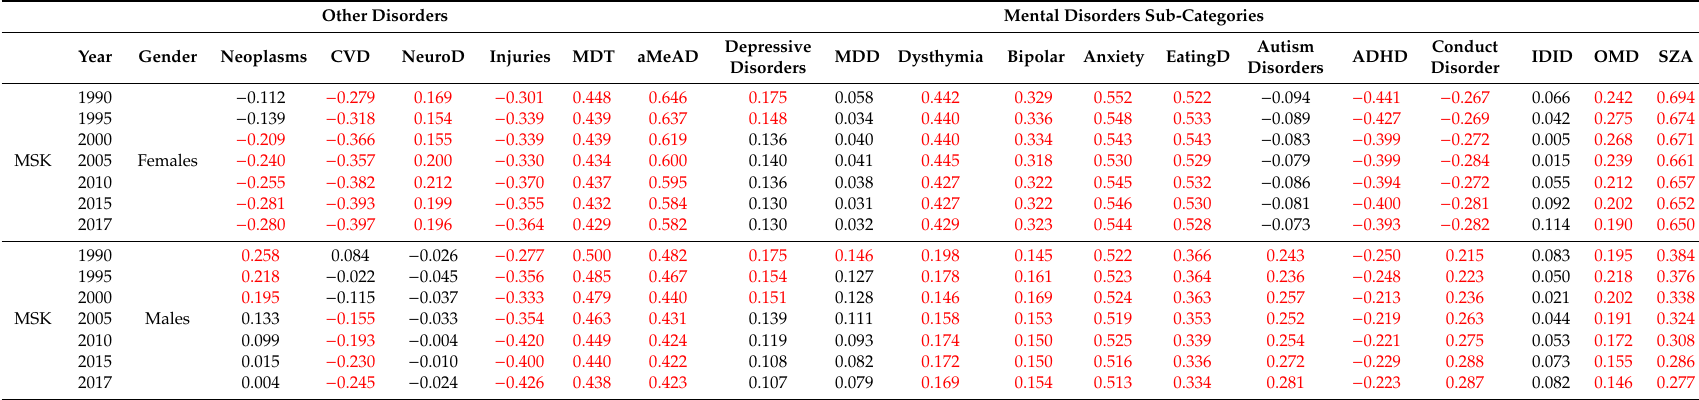
Table 3. Spearman’s correlation coe ffi cients between age standardized DALYs attributed to musculoskeletal disorders and age-standardized DALYs attributed to various disorders, among 195 countries, in males and females, for 1990 to